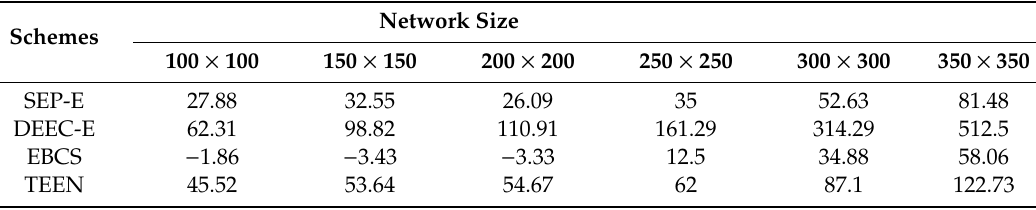
Table 9. Percentage Improvement of hesitant fuzzy entropy-based opportunistic clustering and data fusion scheme (HFECS) in terms of stability period.